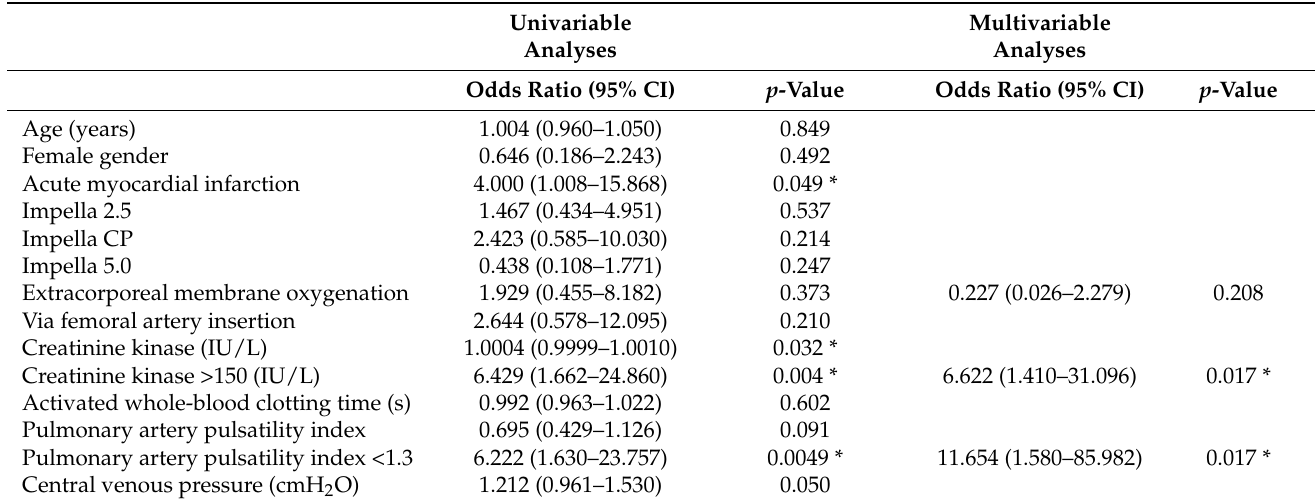
Table 4. Univariable and multivariable analyses for the hemolytic event.